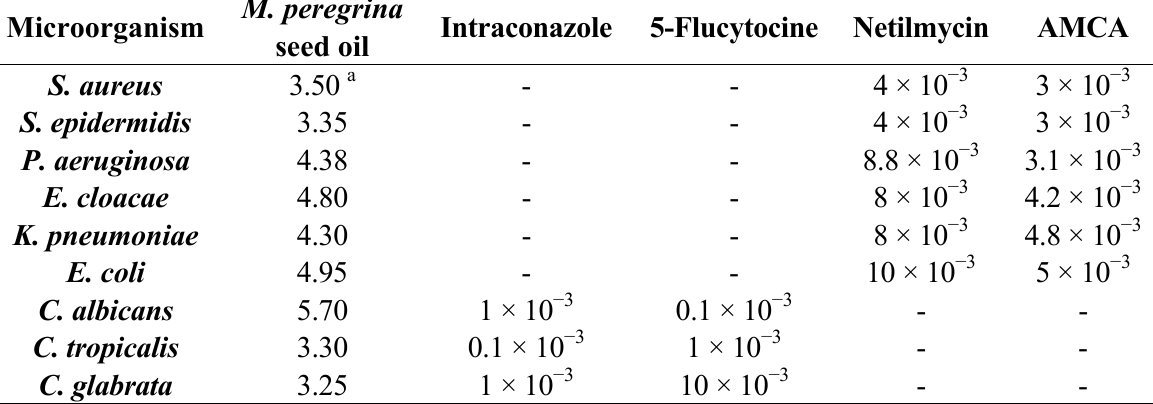
Table 1. Minimal inhibitory concentrations (MIC) of the oil (extracted with n -hexane from the seeds of M. peregrina ) and standard antibiotics on test organisms (in mg/mL).